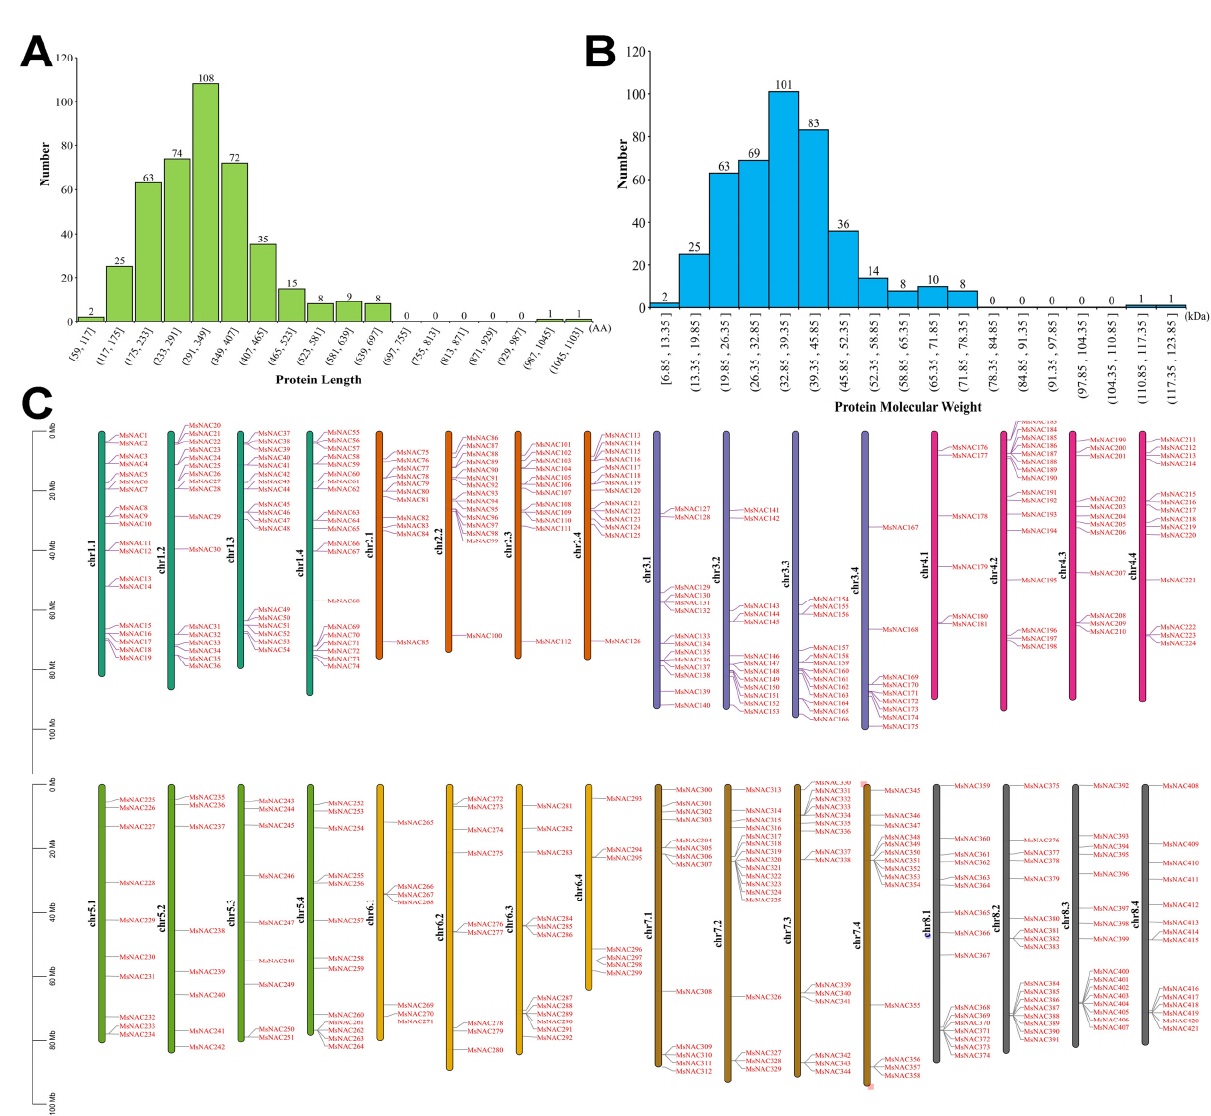
Figure 1. The characteristics and genome positions of MsNAC members in M. sativa . ( A ), Protein sequence length distribution; AA, amino acid. ( B ), The protein molecular weight distribution. ( C ), The position of MsNAC members in the alfalfa